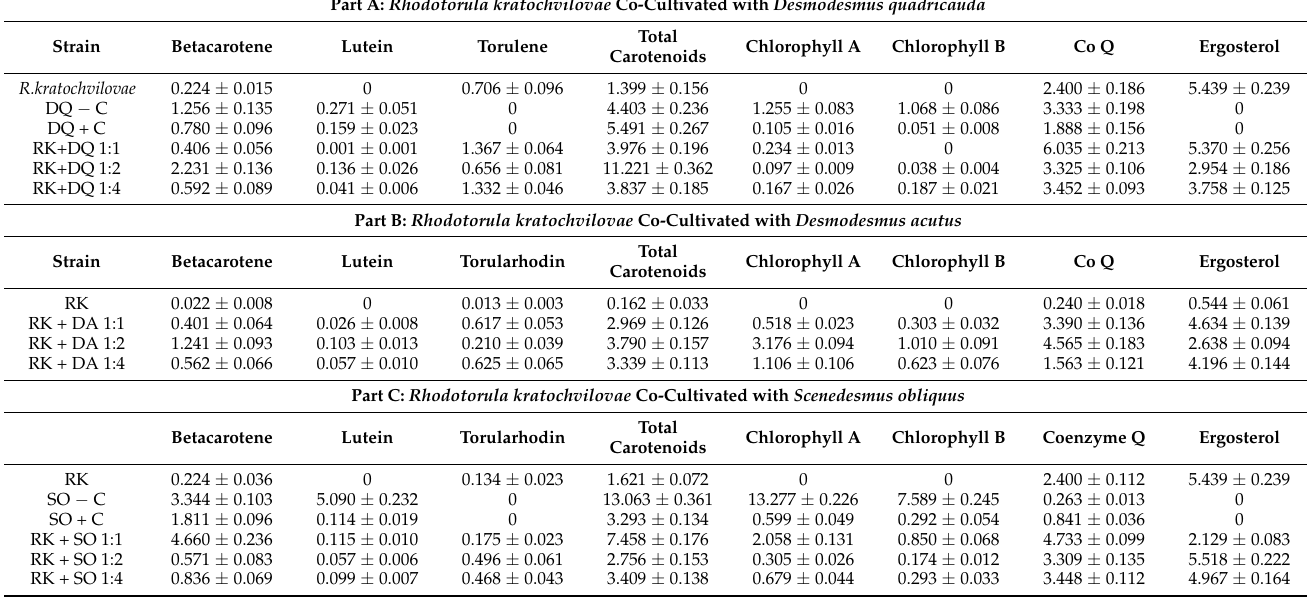
Table 2. Production of pigments and sterols by R. kratochvilovae co-cultivated with representatives of the genera Desmodesmus and Scenedesmus in aerated pyrex flasks (mg/g